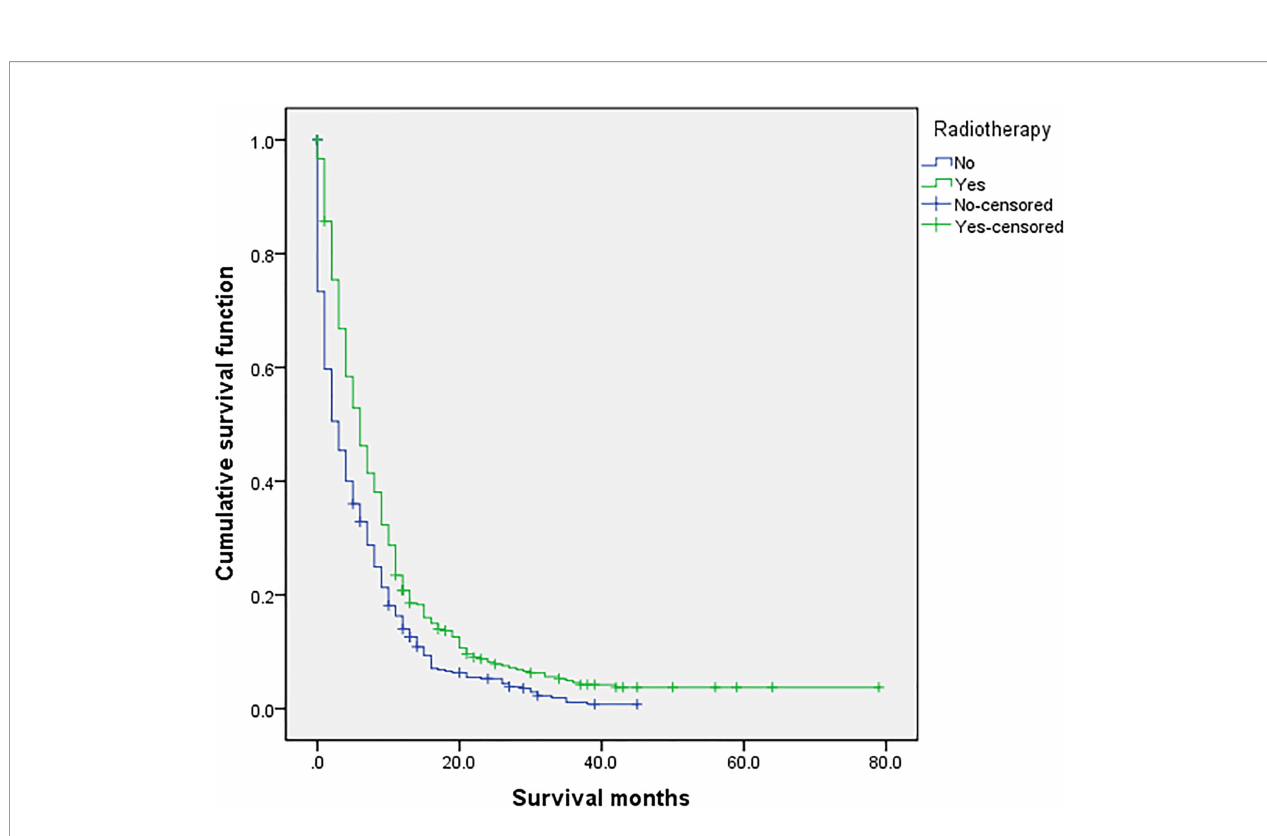
FIGURE 4 | Univariate analysis of with or without radiotherapy. In the organ metastasis group (n = 870), univariate analysis of with or without radiotherapy showed that P < 0.001 was obtained by Kaplan – Meier survival analysis log rank (mental Cox). There was signi fi cant difference between the two groups.